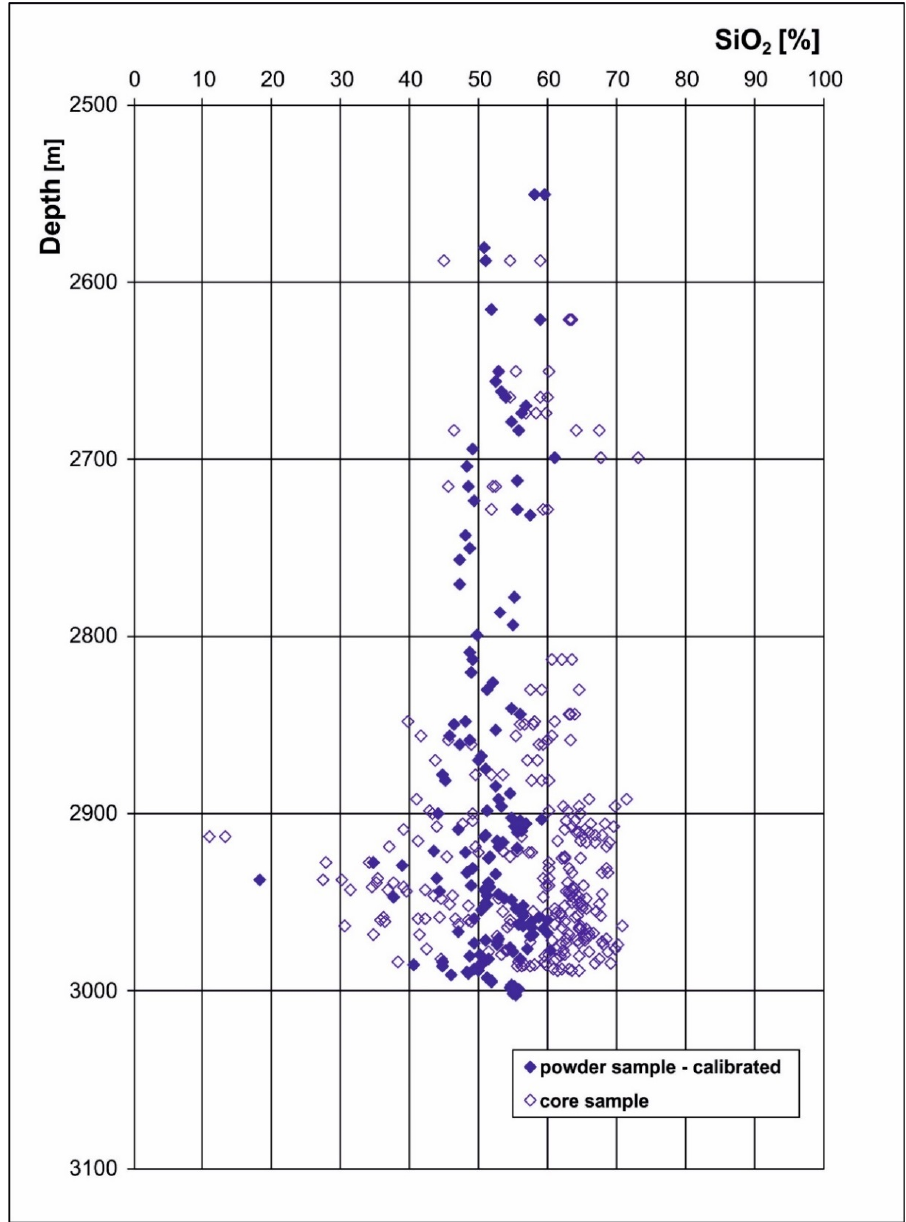
Figure 5. Correlation of results regarding measurements taken on powder samples and directly on cores for fine-grained rocks (the Silurian, the W-1 borehole). It is an illustration of the impact of the grain size on the pXRF measurement results.